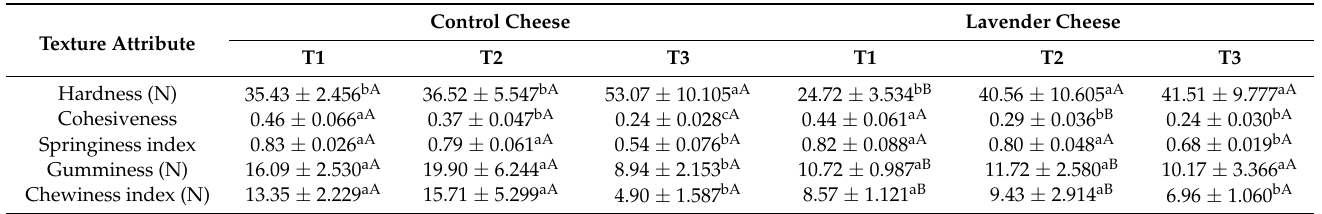
Table 2. Texture attribute values for control and lavender Gouda-type cheese at different ripening times (T1, T2, and T3).